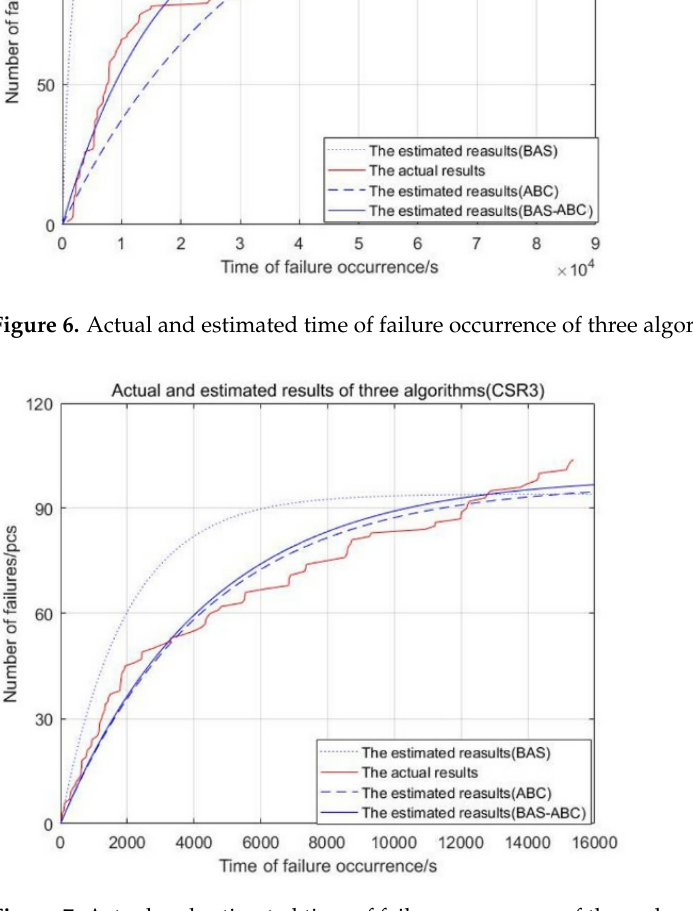
Figure 7. Actual and estimated time of failure occurrence of three algorithms (CSR3).